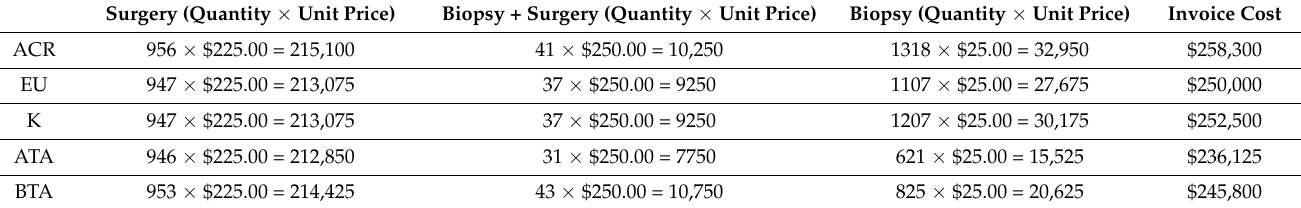
Table 22. SSI-invoiced unnecessary